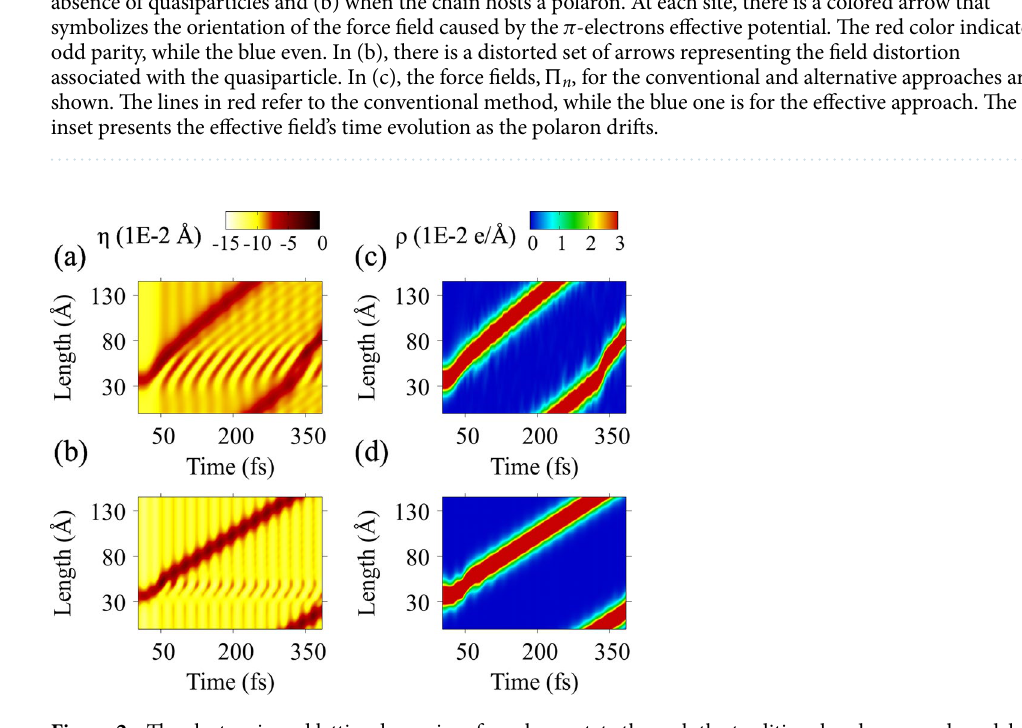
Figure 2. The electronic and lattice dynamics of a polaron state through the traditional and proposed model. Figures (a) and (b) refer to the lattice order parameter, η n ≡ ( y n + 1 − 2 y n + y n − 1 )/ 4 , calculated via the conventional and the effective potential approaches, respectively. Light and dark tones indicate the distortion intensity. The localized dark-colored region refers to the polaron. On the other hand, (c) and (d) show the | ψ k , s ( n , t ) | 2 , using the traditional procedure and the effective chain’s charge density time evolution, ρ( t ) ≡ k , s potential, respectively. Here, hot colors represent charge accumulation, while cold ones indicate the absence of (cid:31)